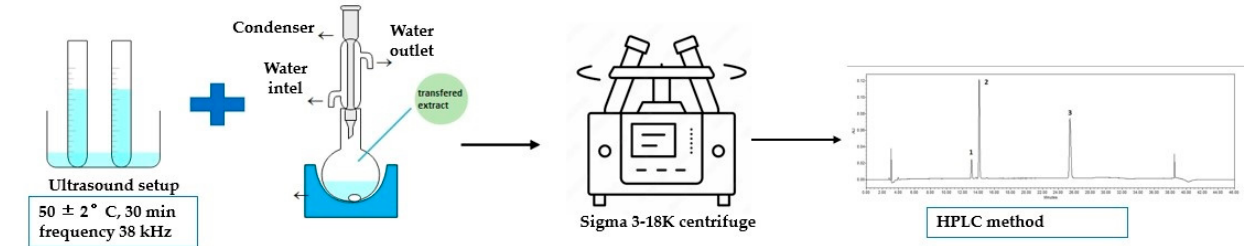
Figure 6. Combined extraction method schema.